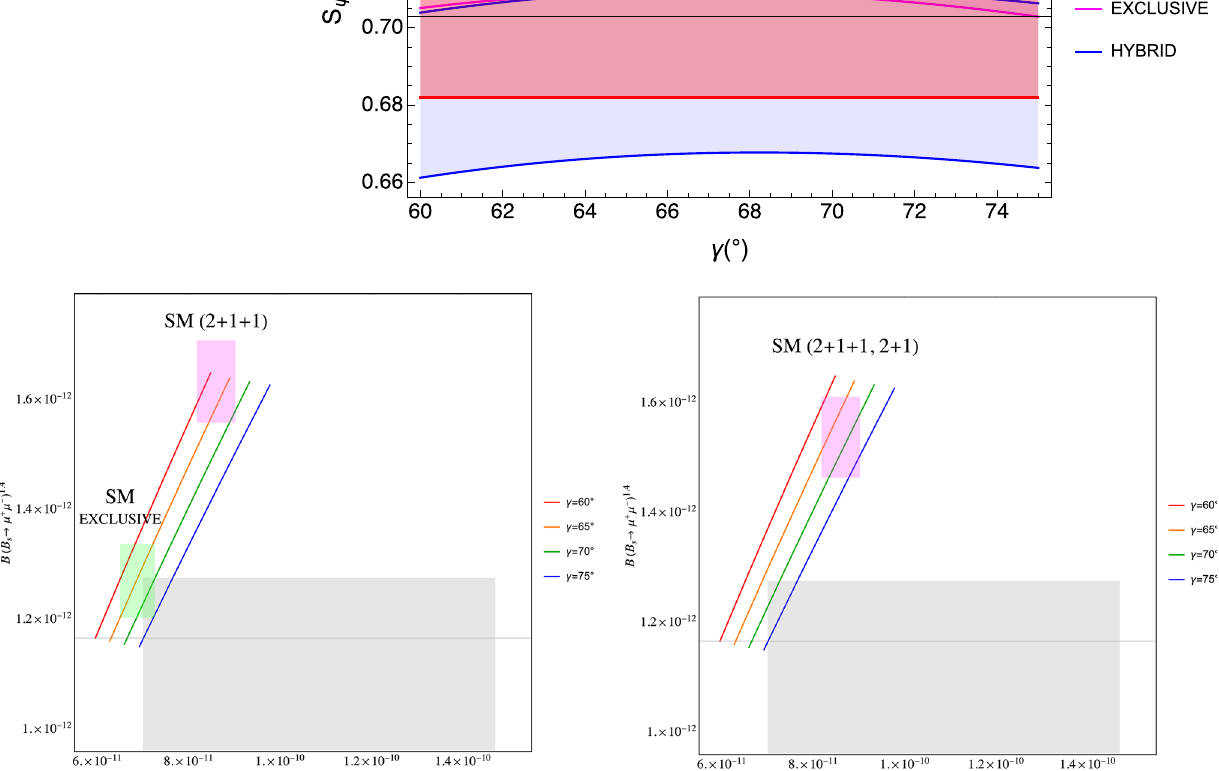
2 + 1 average (right panel) used in [7]. The green area represents the EXCLUSIVE scenario and the gray area the present experimental situ-